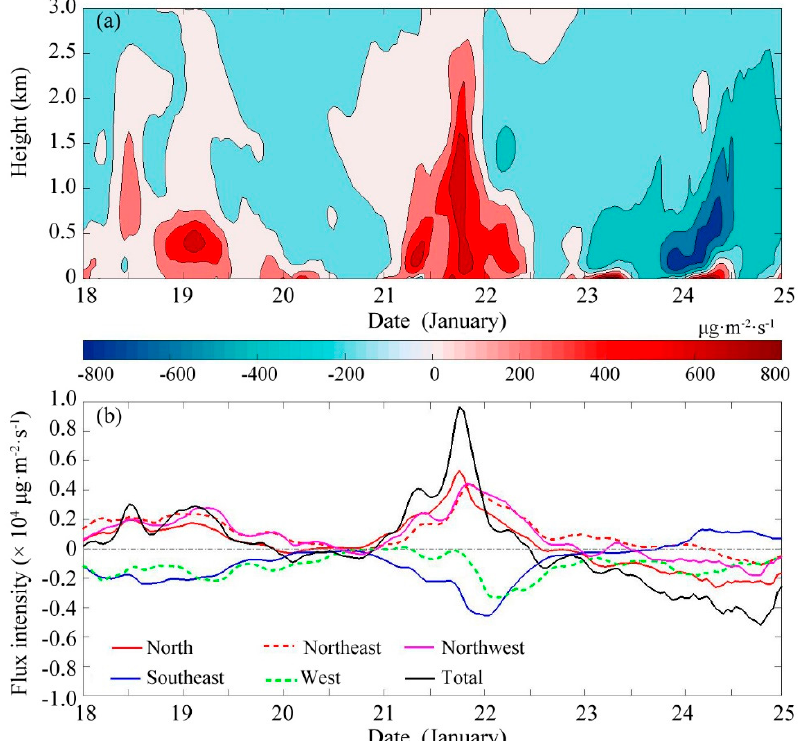
Figure 14. Time series of the PM 2.5 ( a ) transport intensity variation with height in the PRD region (shaded; unit: µ g · m − 2 · s − 1 ), ( b ) average transport flux intensity at each boundary and the total transport flux intensity at all boundaries (unit: × 10 4 µ g · m − 2 · s − 1 ) below 3 km.